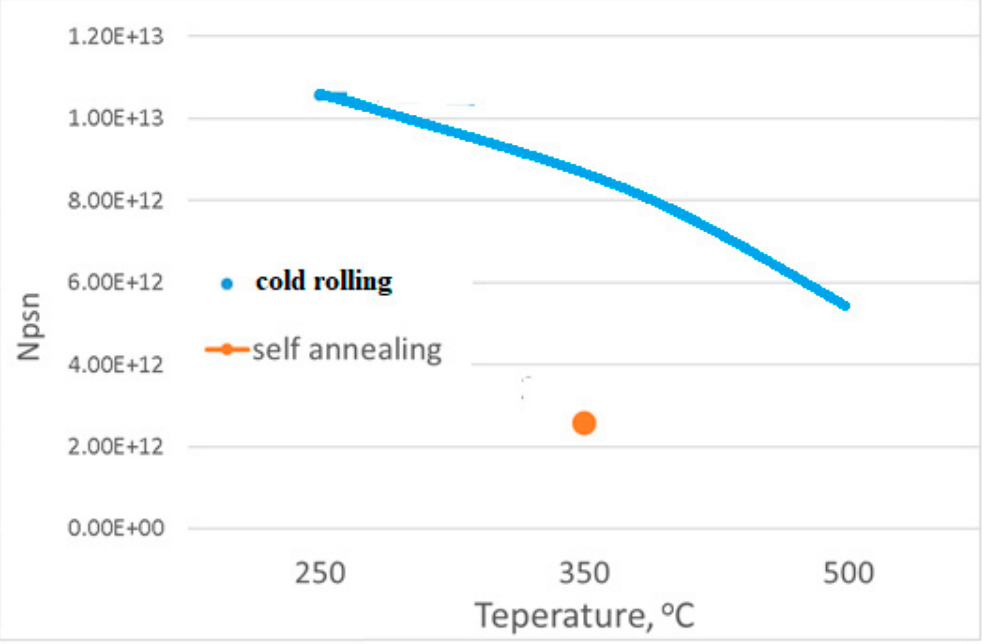
Figure 20. The amount of particles which can contribute to recrystallization (according to the driving and retarding forces for recrystallization and their dependence on the annealing